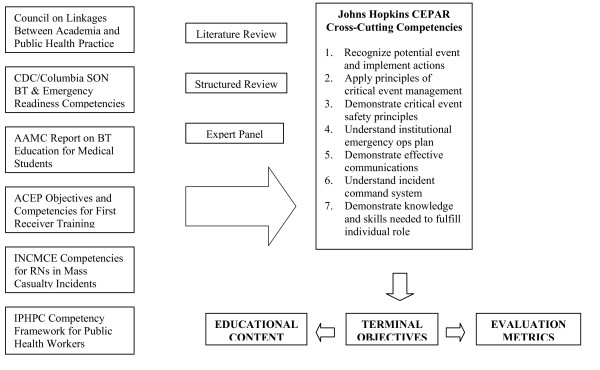
Development of cross-cutting competencies.